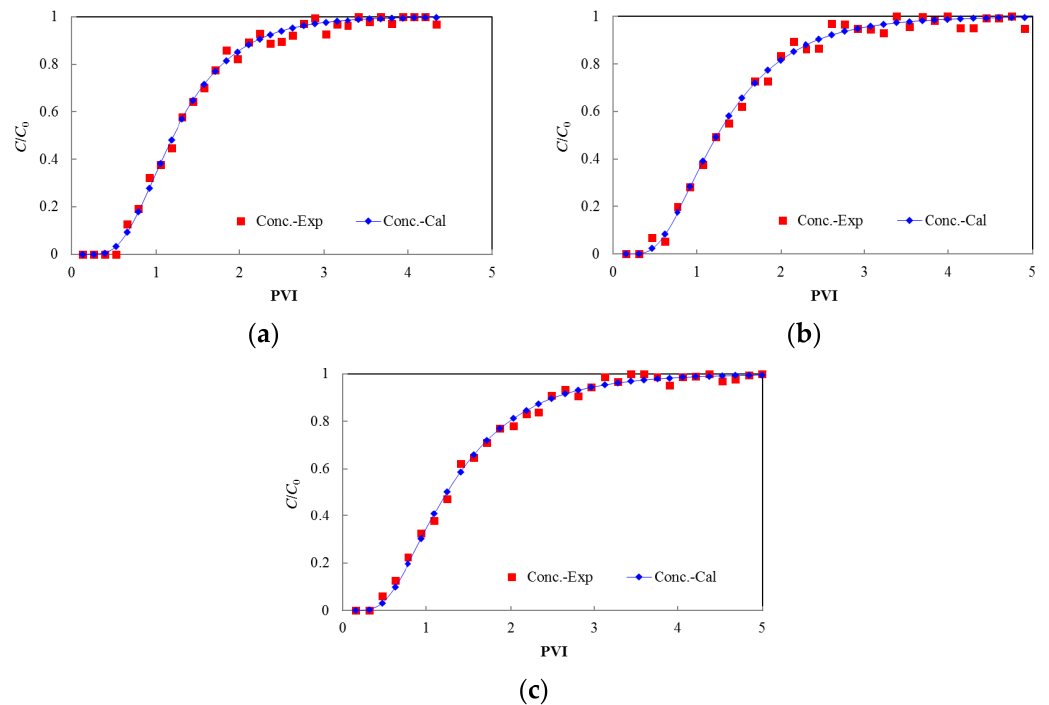
Figure 4. Data fitting for tracer concentration ratio versus pore volume injected (PVI) at low flow rate (0.02 cm 3 /s) in natural cores: ( a ) core No. 1 (1570 mD), ( b ) core No. 2 (610 mD), and ( c ) core No. 3 (230 mD).